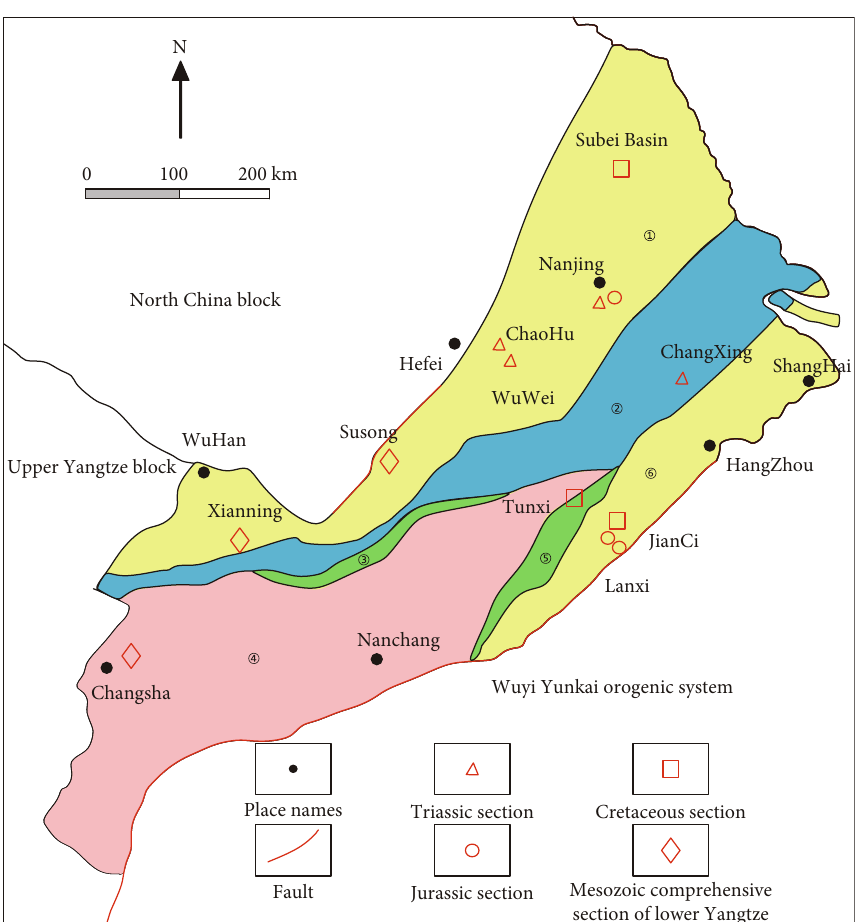
Figure 3: Stratigraphic map of lower Yangtze region [15].